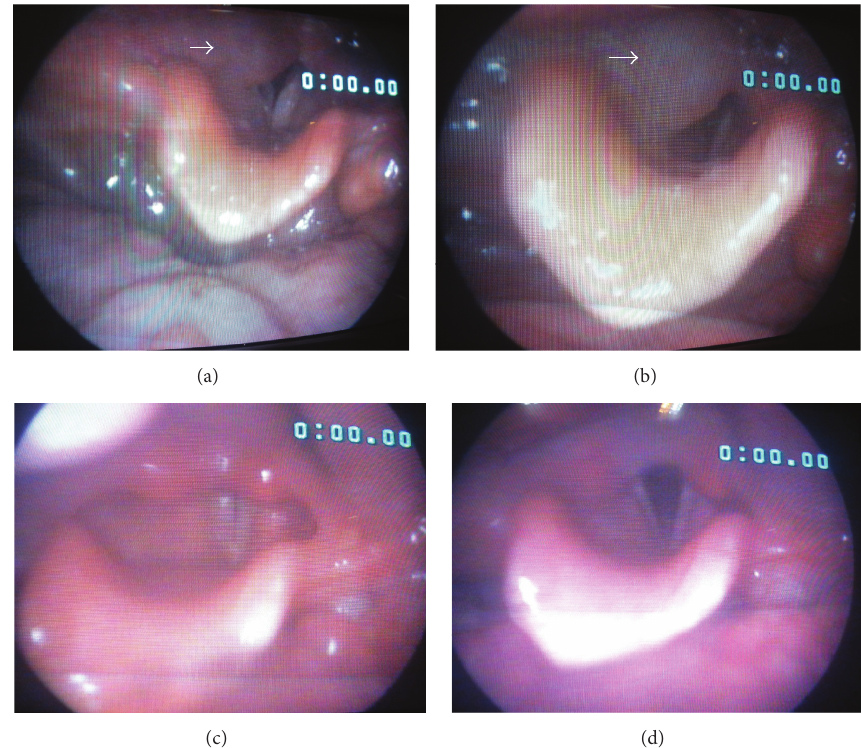
Figure 1: The stroboscopic view of the laryngeal lesion before (upper row: (a), (b)) and after (lower row: (c), (d)) radiotherapy.